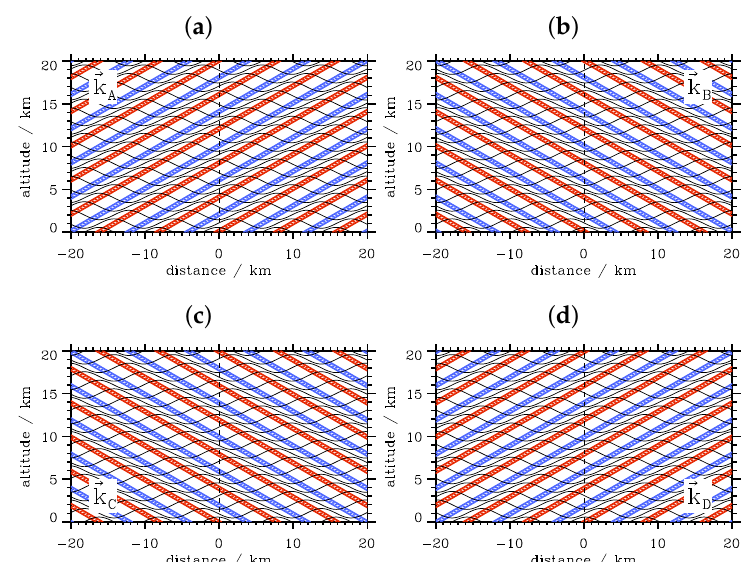
Figure 3. Spatial snapshots of the vertical displacements ξ ( x , z , t ) of horizontally- and vertically-propagating plane waves for the four wavenumber vectors (cid:126) k A ( a ), (cid:126) k B ( b ), (cid:126) k C ( c ) and (cid:126) k D ( d ) at t = 24min, respectively. The values of the horizontal and vertical wavenumber components are k = ± 2 π / λ x with λ x = 8km and m = ± 2 π / λ z with λ z = 4km, respectively. Red and blue contour lines refer to ± 0.95 times the wave amplitude and illustrate phase lines. The dashed black lines refer to the horizontal position where the vertical time series shown in Figure 4 are recorded.